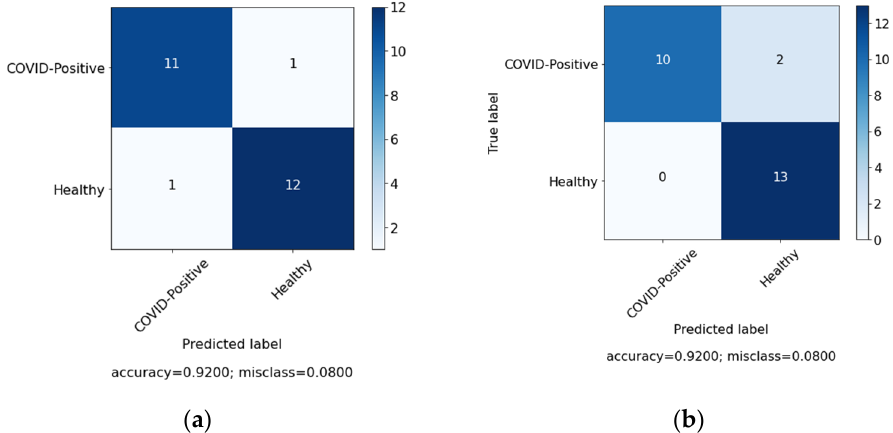
Figure 9. Diagnosis comparison for case 1 (clinical data). ( a ) Expert diagnosis. ( b ) System diagnosis.